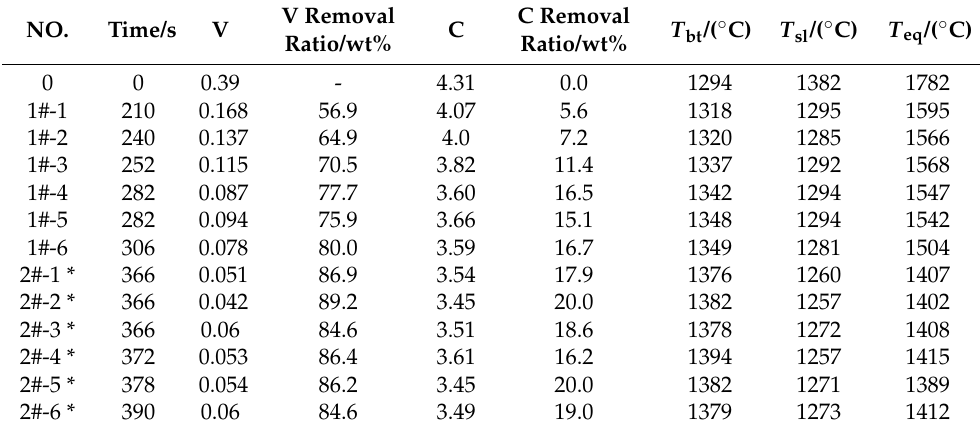
Table 5. Removal ratios, T sl and T eq in various time during industrial experiments. NO.